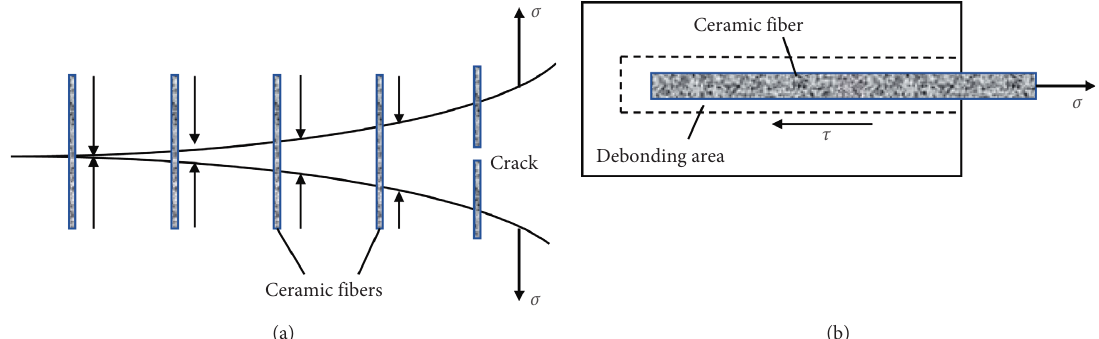
Figure 16: Microscopic force diagram: (a) bridging effect and (b) pulling-out